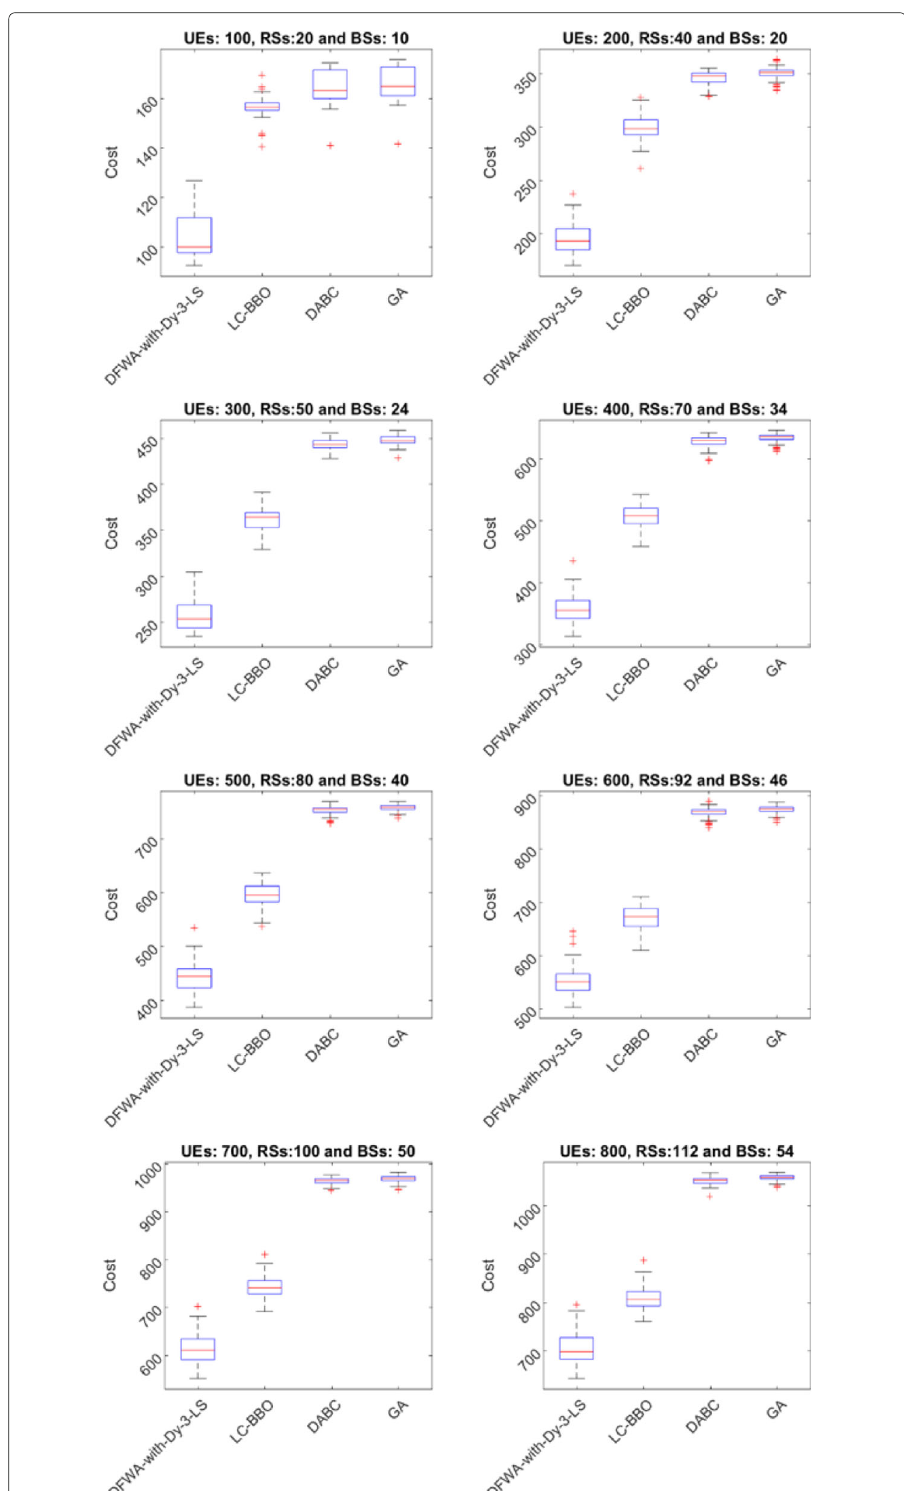
Fig. 6 Boxplots for all instances with various configurations of RSs and